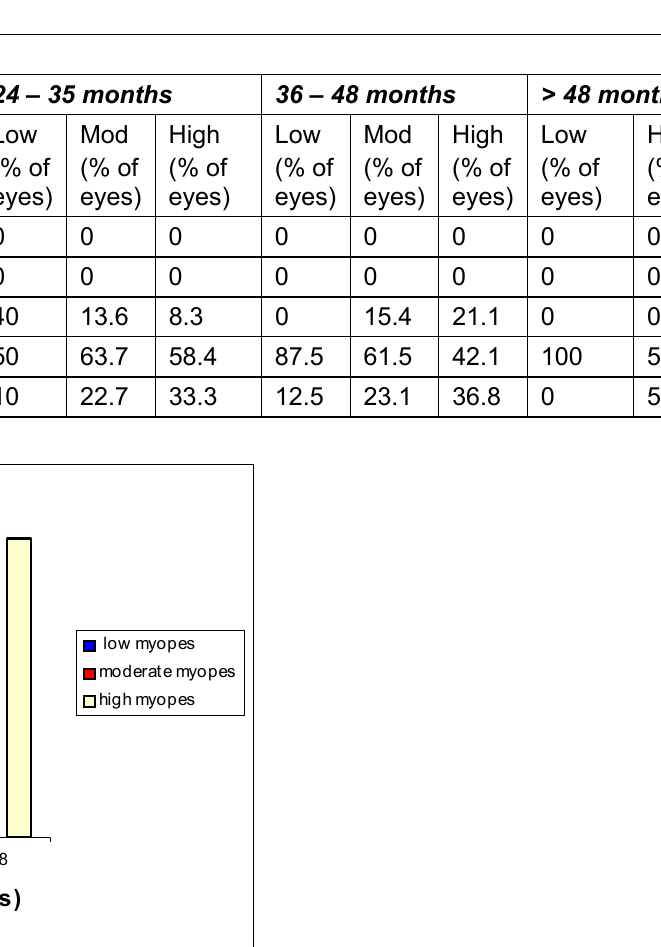
Figure 2 .Mean glare vision thresholds according to degree of pre-operative refractive error and the post-operative interval